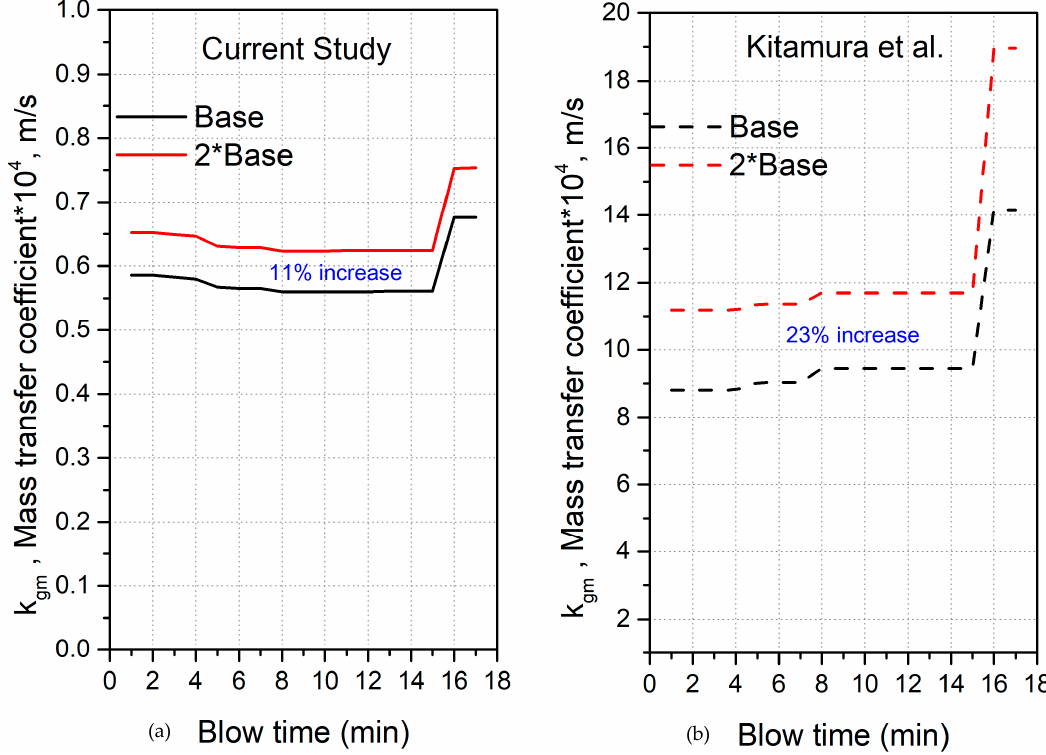
Figure 6. Comparison of metal phase mass transfer coefficients calculated by ( a ) Current model and ( b ) correlation obtained from the study of Kitamura et al. [20].